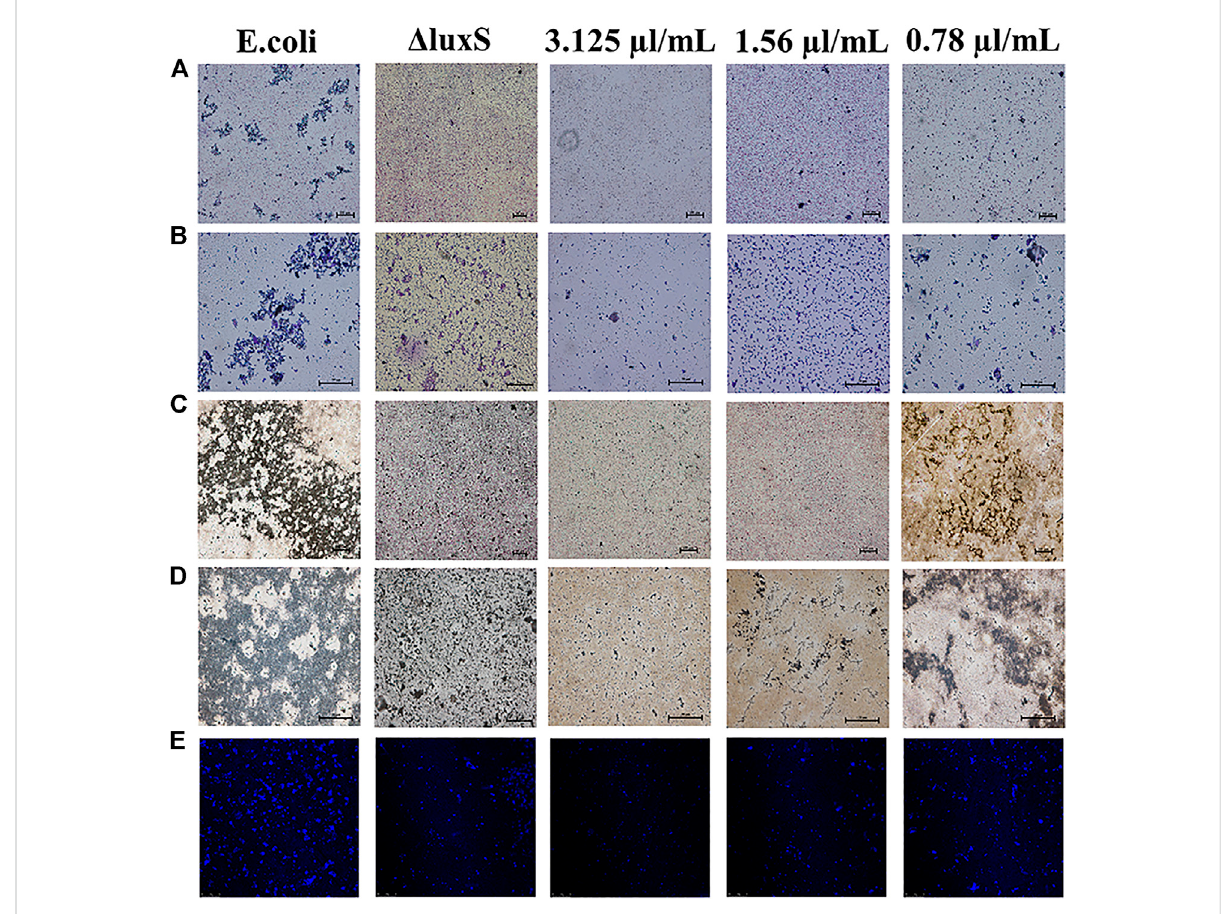
FIGURE 3 Differentin fl uencingfactorsonthemicrostructureofbacterialbio fi lms. (A – E) Effectof luxS genedeletionandnon-inhibitoryconcentrationsof 1,8-cineole (3.1,1.55,0.78and0 μ g/ml)ontheamount ofbio fi lmformationof E.coli O101underlightmicroscopyandCLSM. (A , B) :Crystalline violet staining 100× and 400×; (C , D) : Silver staining 100× and